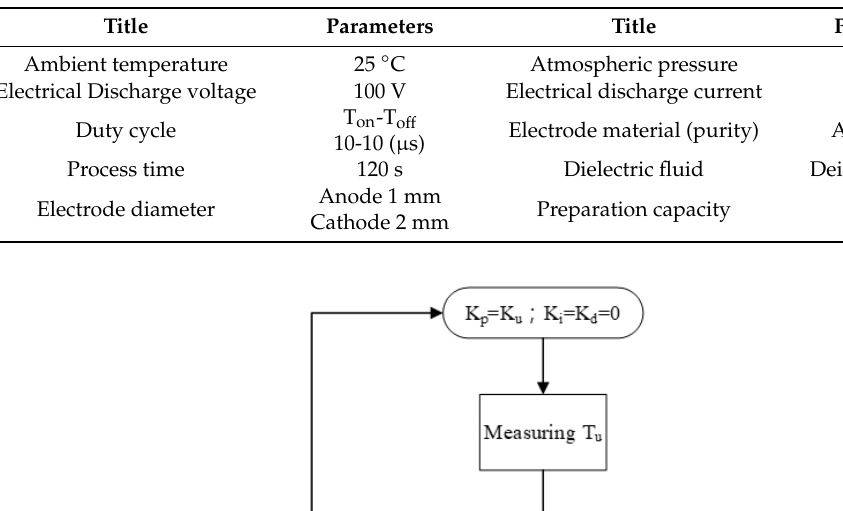
Table 2. Process parameters.